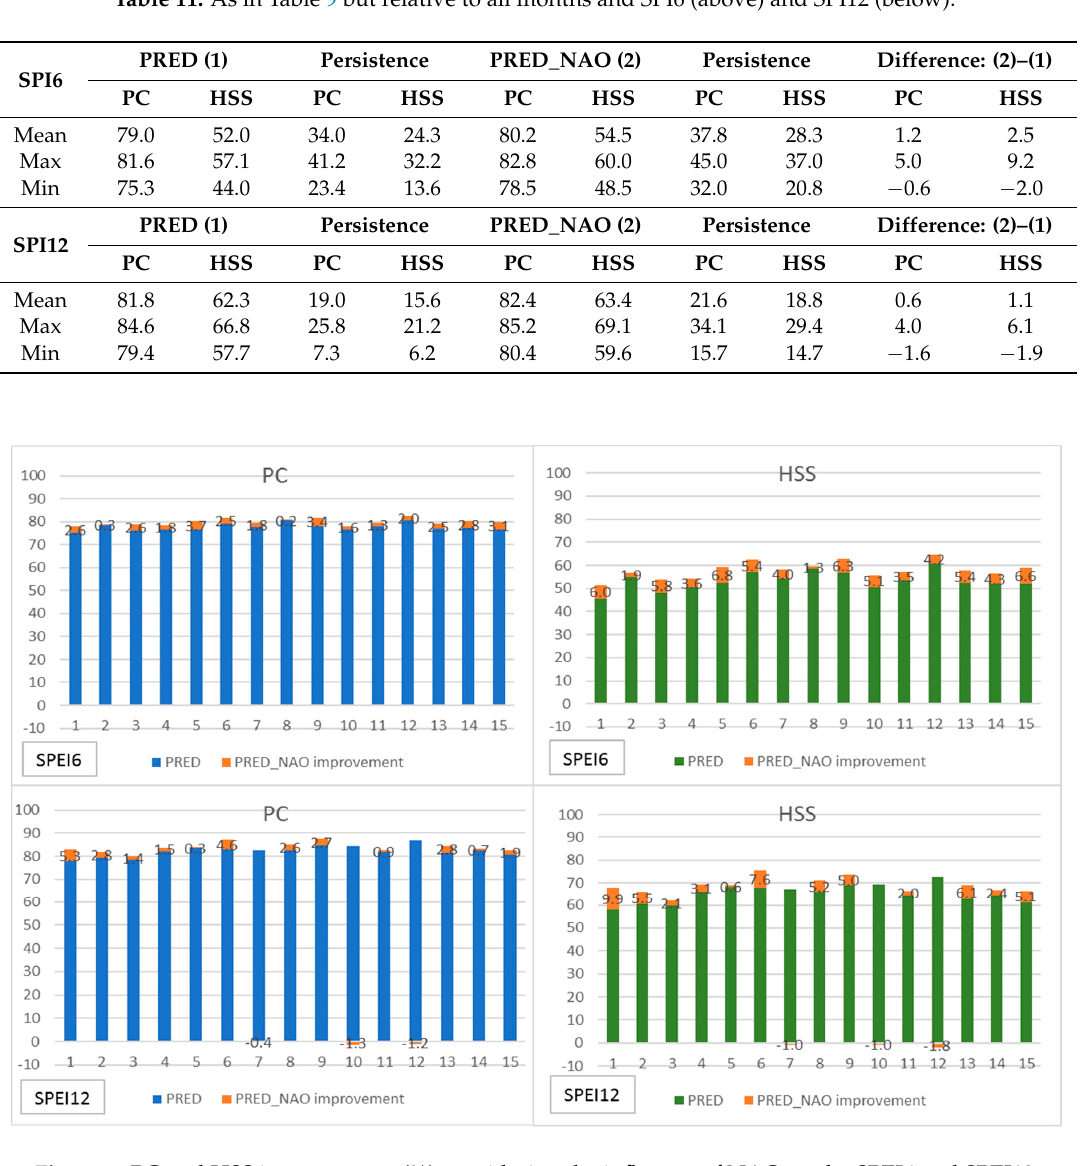
Figure 6. PC and HSS improvement (%) considering the influence of NAO on the SPI6 and SPI12 modeling for the extended winter months for each of the 15 grid points.